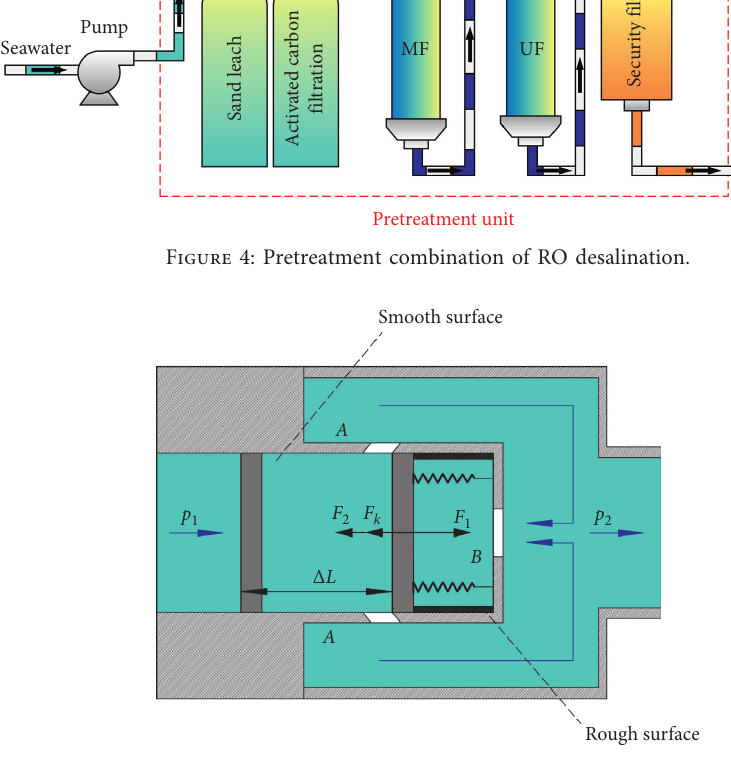
Figure 5: Structure diagram of constant pressure reducing valve. Table 1: Concentration of major ions contained in deep seawater at depth of 1000m and their upper limits specified in standard for drinking water by